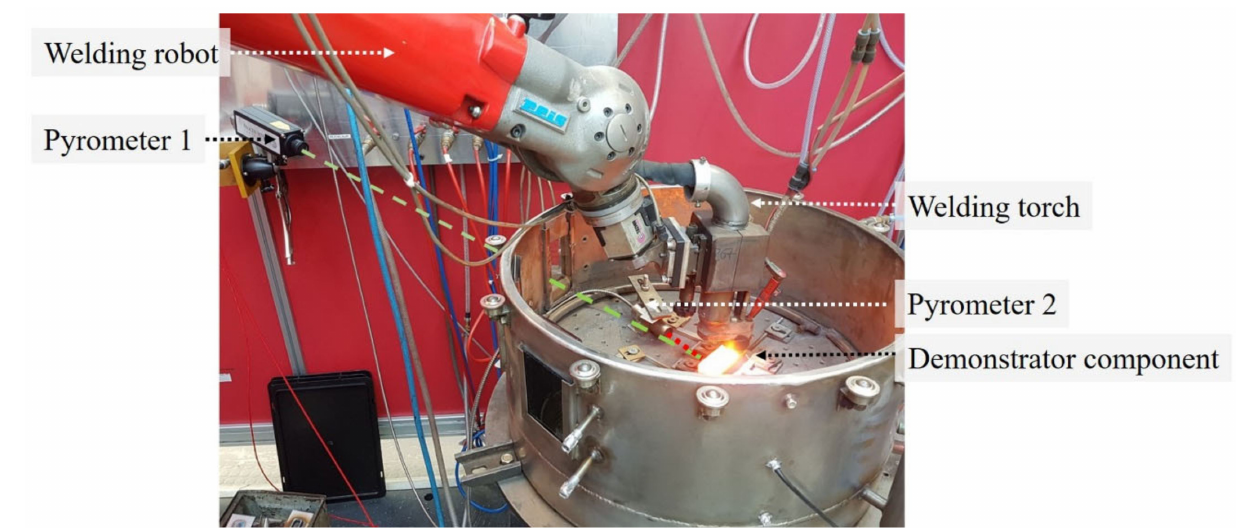
Figure 1. Experimental setup of the additive process 3DPMD.